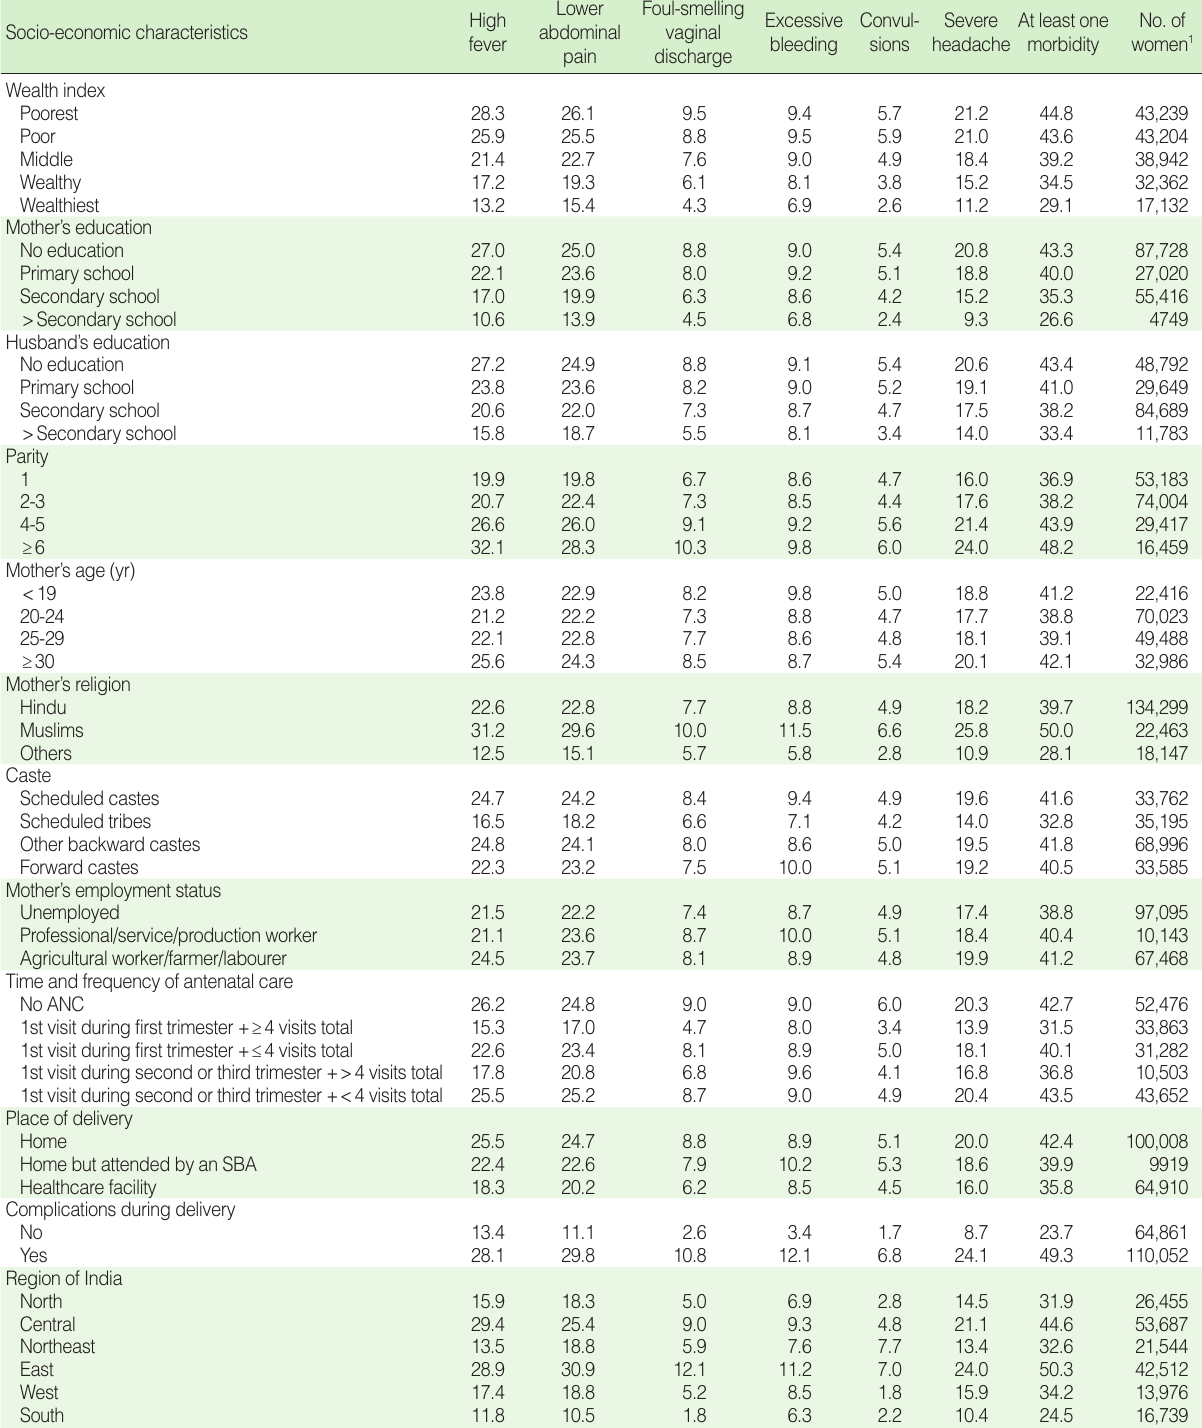
Table 1. Prevalence of postpartum morbidities by selected background characteristics among currently married women (aged 15-49 years) in rural India,